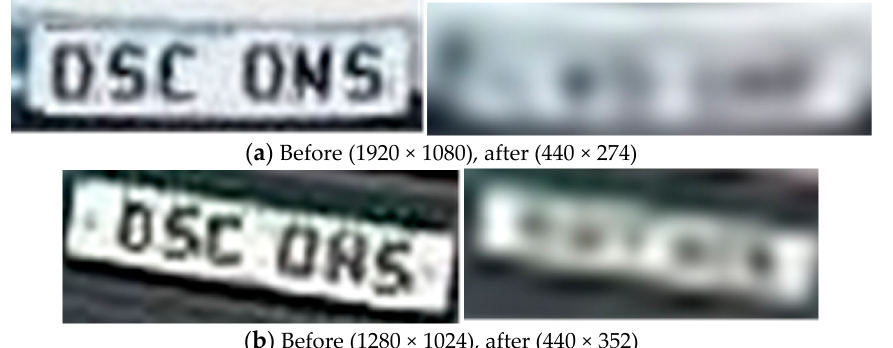
Figure 8. Modified examples of disclosive number plates captured on traffic cameras.